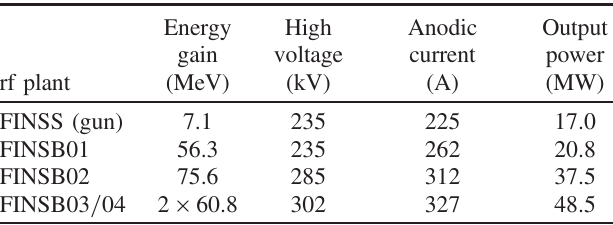
TABLE VI. Energy gains provided by the S-band rf plants and corresponding klystron operational parameters.